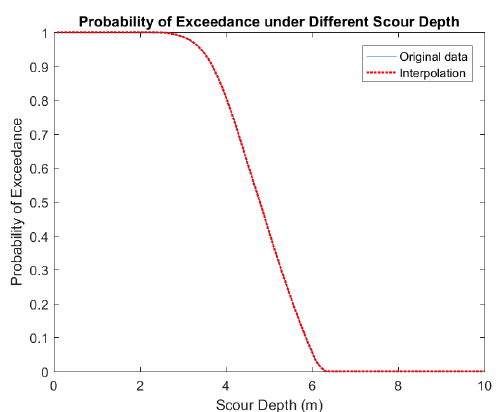
Figure 10. Scouring depth exceeding probability for the 100 year return period.